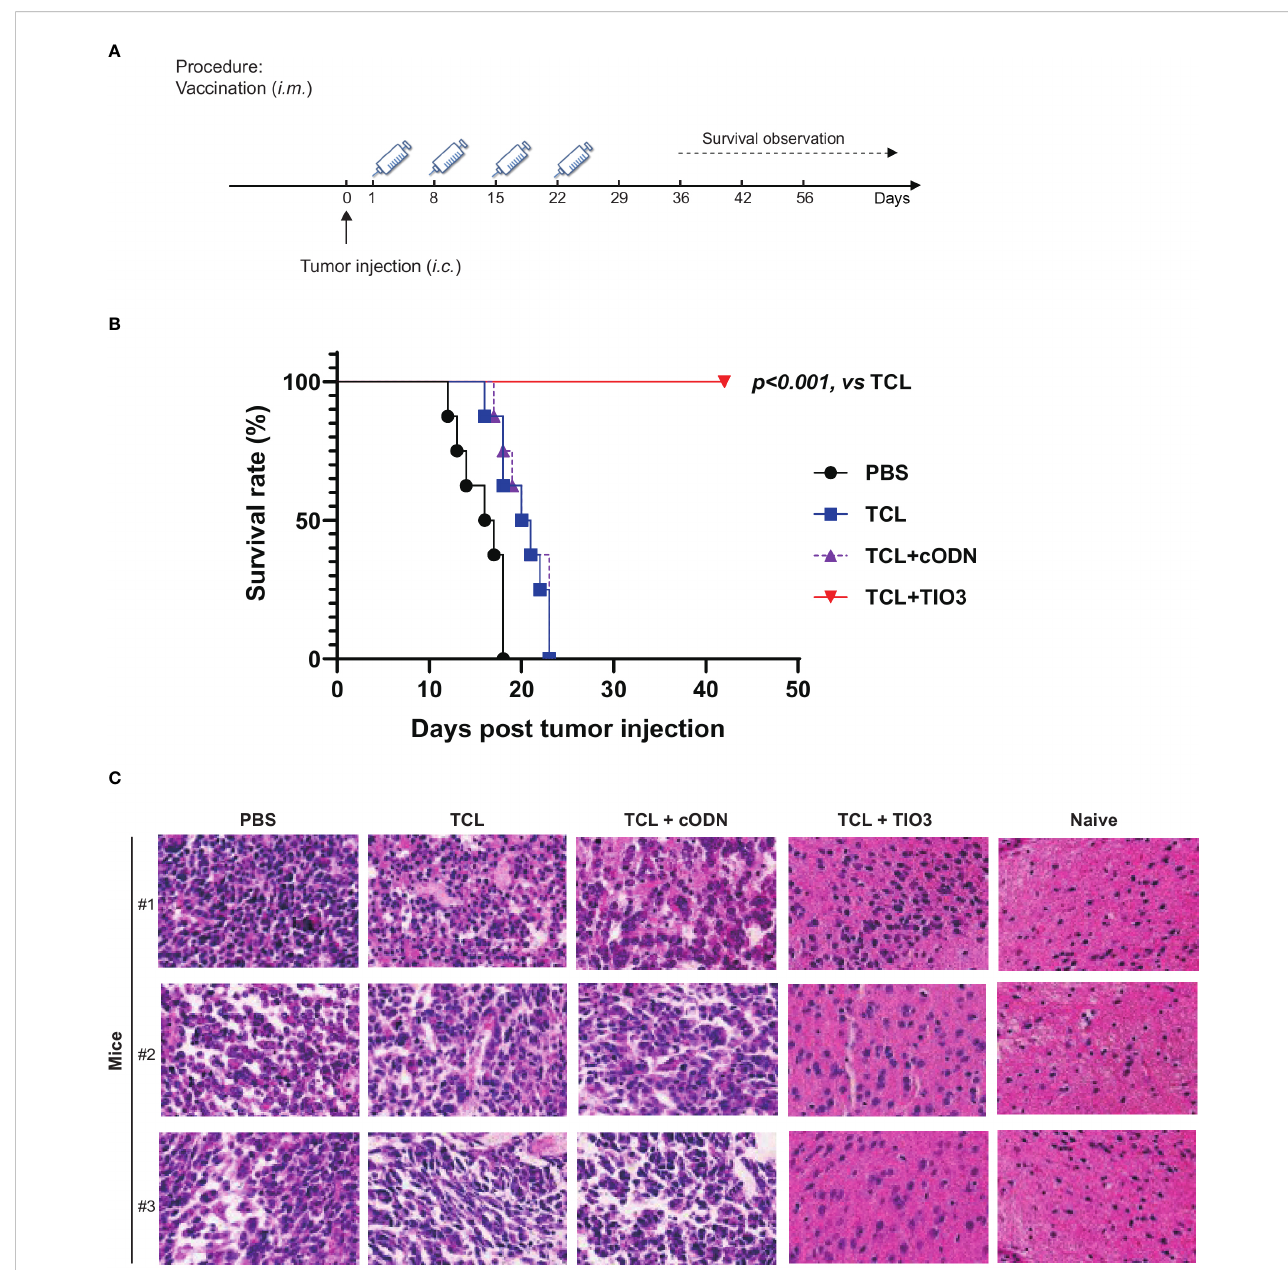
FIGURE 7 Therapeutic protective effect of TIO3 as vaccine adjuvant on the in-situ glioma model in mice. TIO3 as a glioma vaccine molecular adjuvant combined with GL261 TCL to treat GL261-bearing mice. (A) The experimental procedure: C57BL/6 mice (n=8) were intracranial (i.c.) inoculated with 2×10 4 GL261 cells in right caudate nucleus of the brains on day 0, and then were i.m. immunized in the neck with PBS, TCL, TCL+TIO3 or TCL+cODN on day 1, 8, 15 and day 22. (B) The survival of GL261-bearing mice. (C) Brain tissues were taken for histopathological examination with HE staining analysis on the 18th day. The three mice received PBS died within 18 days after the GL261 cell inoculation, and their brain samples were analyzed immediately after death. (Magni fi cation,